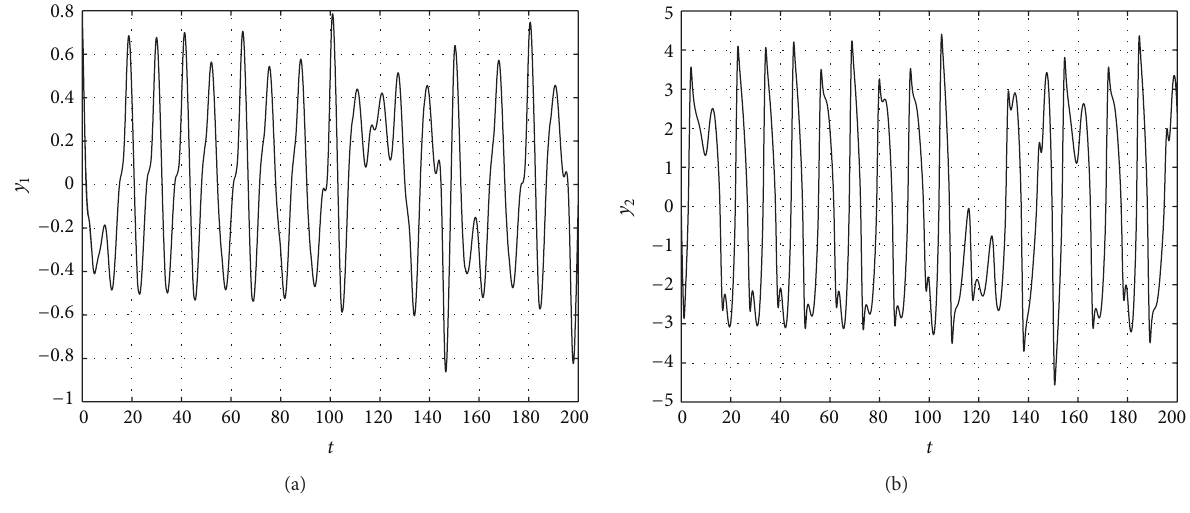
Figure 3: State trajectories of response system.